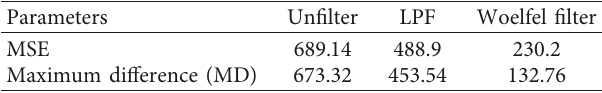
Figure 15: Comparison plot for NAE, SC, and NCC values. Table 2: Parametric comparison of MSE and MD for filters.